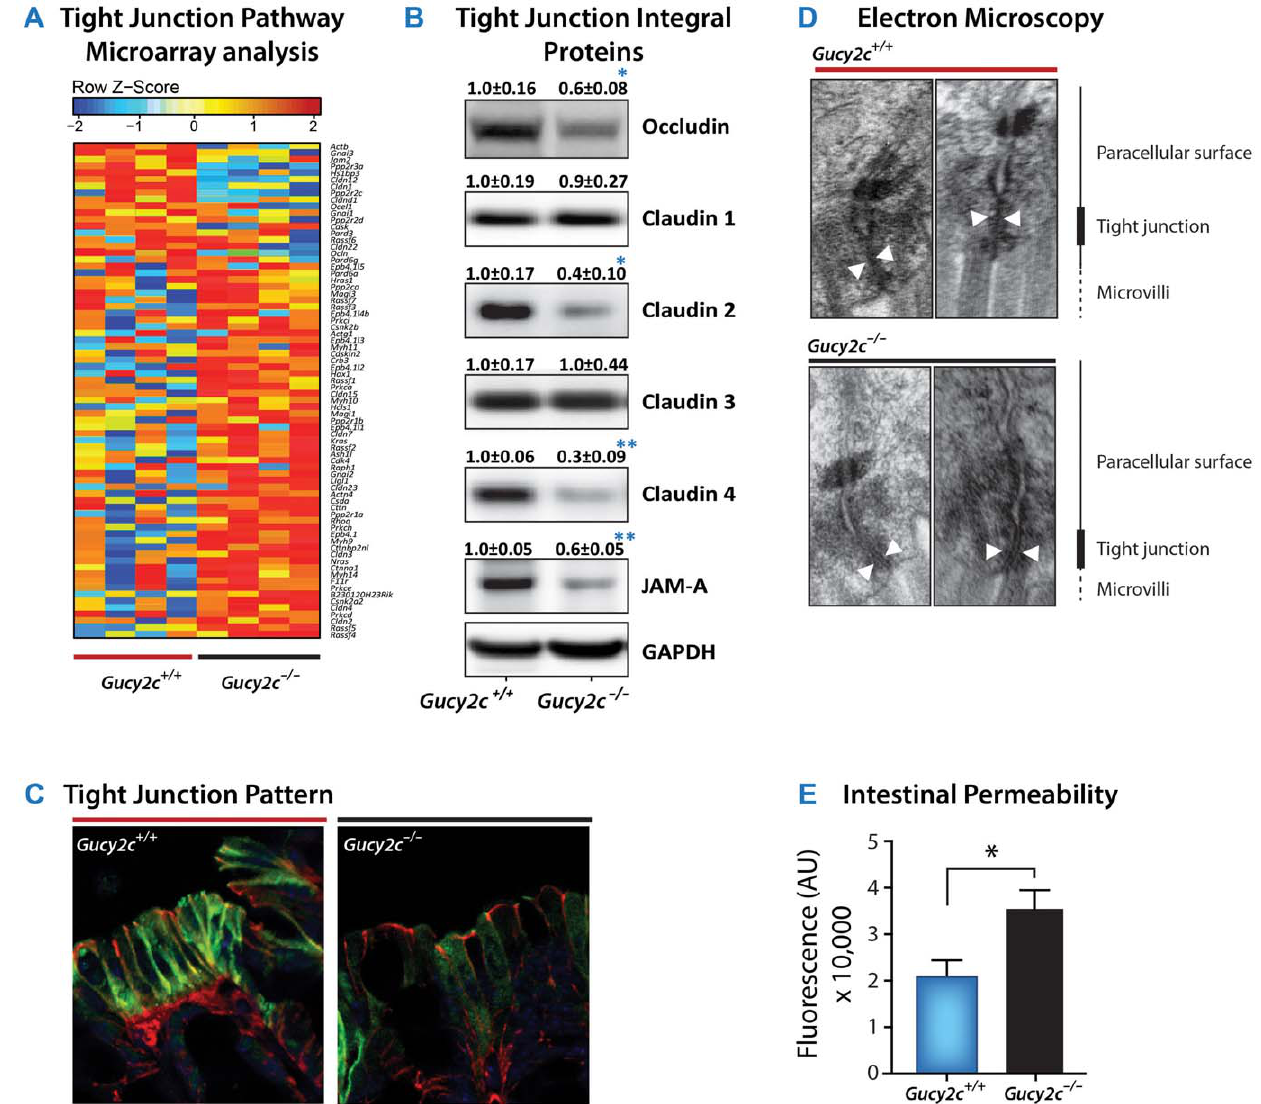
Figure 1. GUCY2C regulates intestinal barrier integrity. ( A ) Comparison of mRNA expression of genes associated with the canonical tight junction pathway (KEGG 04530) of Gucy2c + / + and Gucy2c 2 / 2 mice (n=4, p=0.029). ( B ) Immunoblot analysis of tight junction proteins from the distal colon of 12 week old Gucy2c + / + and Gucy2c 2 / 2 mice. Data represent means of n $ 7 6 SEM. ( C ) Immunofluorescence staining of claudin 4 from the distal colon of 12 week old Gucy2c + / + and Gucy2c 2 / 2 mice. (Nucleus-DAPI, b -catenin-red, Claudin 4-green; 1,000 6 ). ( D ) Transmission electron microscopy of tight junction complexes from jejuna of 12 week old Gucy2c + / + and Gucy2c 2 / 2 mice (25,000 6 ). ( E ) FITC-dextran was administered by oral gavage to age-matched Gucy2c + / + and Gucy2c 2 / 2 mice after an overnight fast. Serum fluorescence was analyzed 90 min after gavage. One representative experiment of three (n=3). *, p , 0.05, **, p , 0.01. doi:10.1371/journal.pone.0031686.g001 mice (Fig. 2 A ). Also, DSS colitis was associated with . 80% mortality in Gucy2c 2 / 2 mice, compared to Gucy2c + / + mice which exhibited 100% survival (Fig. 2 B ). Gross and histological pathology revealed that DSS-induced weight loss and mortality was associated with inflammatory shortening of the colon (Fig. 2 C ) and immune cell infiltration disrupting intestinal architecture (Fig. 2 D, E ) in Gucy2c 2 / 2 , compared to Gucy2c + / + , mice. Conversely, enhancing GUCY2C signaling defends the integrity of the intestinal epithelial barrier from disruption by DSS, preventing the associated colitis. Guca2a + mice constitutively express GUCA2A specifically in epithelial cells across the rostral-caudal axis of the intestine when induced by tamoxifen